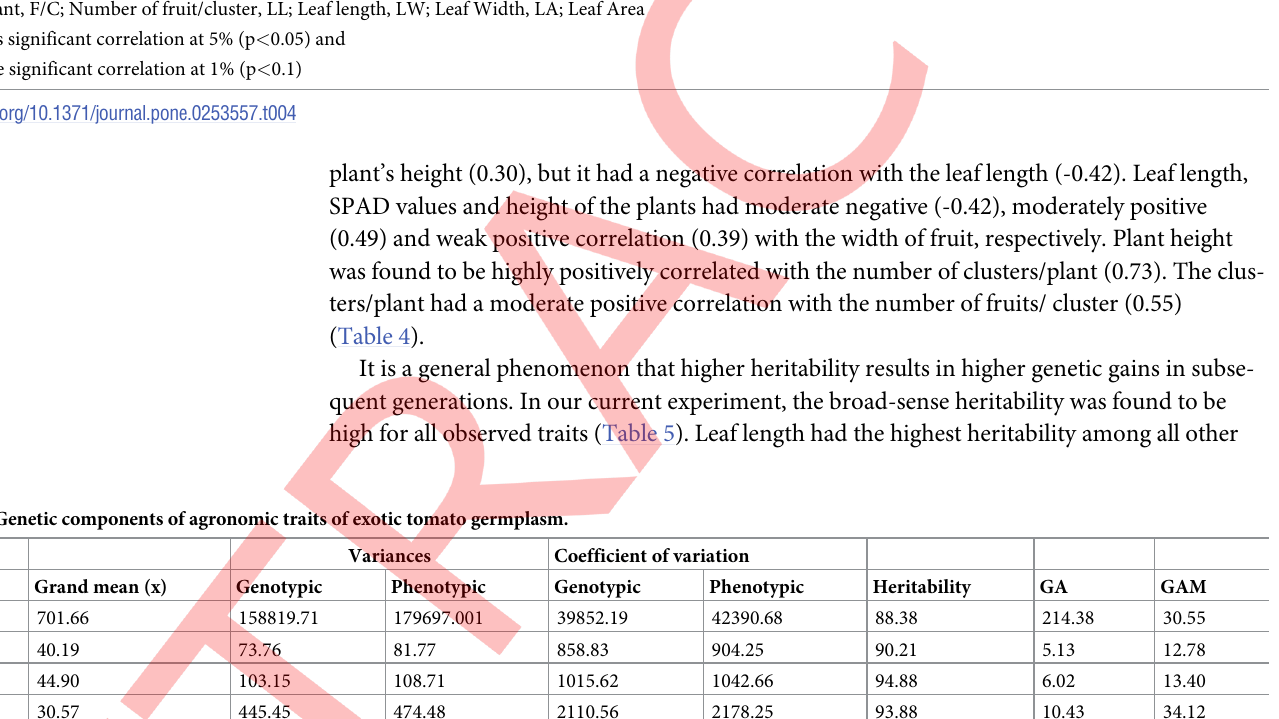
Y/P; Yield/Plant, F. L; fruit length, FW; Fruit width, F/P; Number of fruits/plant, SPAD; SPAD value, TSS; Total soluble solids, PH; Plant height, C/P; Number of cluster/plant, F/C; Number of fruit/cluster, LL; Leaf length, LW; Leaf Width, LA; Leaf Area � indicates significant correlation at 5% (p < 0.05) and �� indicate significant correlation at 1% (p < 0.1)